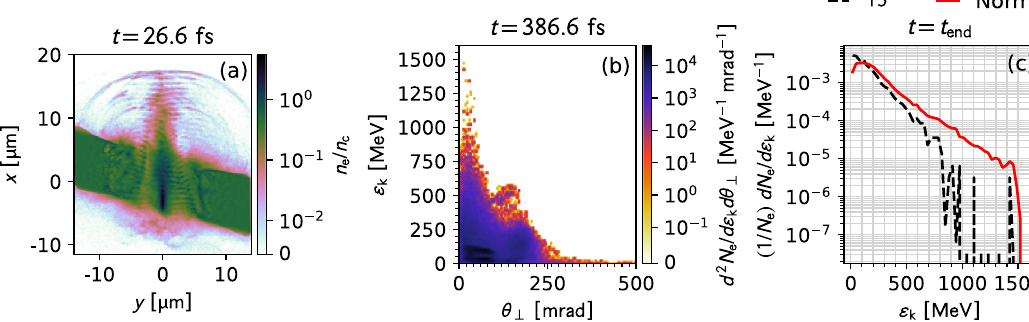
Fig. 5 Optimal regime of electron acceleration at oblique incidence. a Electron density n e normalized to the critical density n c at t = 26.6 fs for a target with an initial maximum electron density n max ¼ 0 : 5 n c . b Electron energy distribution at t = 386.6 fs for different divergence angles q(cid:5) (cid:6) ffiffiffiffiffiffiffiffiffiffiffiffiffiffiffi θ ¼ tan (cid:3) 1 p = p 2 þ p 2 . Only those electrons that have ∣ y ∣≤ 5 μ m and ∣ z ∣≤ 5 μ m are shown in this plot. c Electron energy spectra for the normal ? x y z and oblique cases at the end of each simulation ( t = t end ). The spectra are for the electrons that are closer than 1 μ m to the axis of the laser beam. Here t end = 398.3 fs for the case of normal incidence and t end = 386.6 fs for the case of oblique